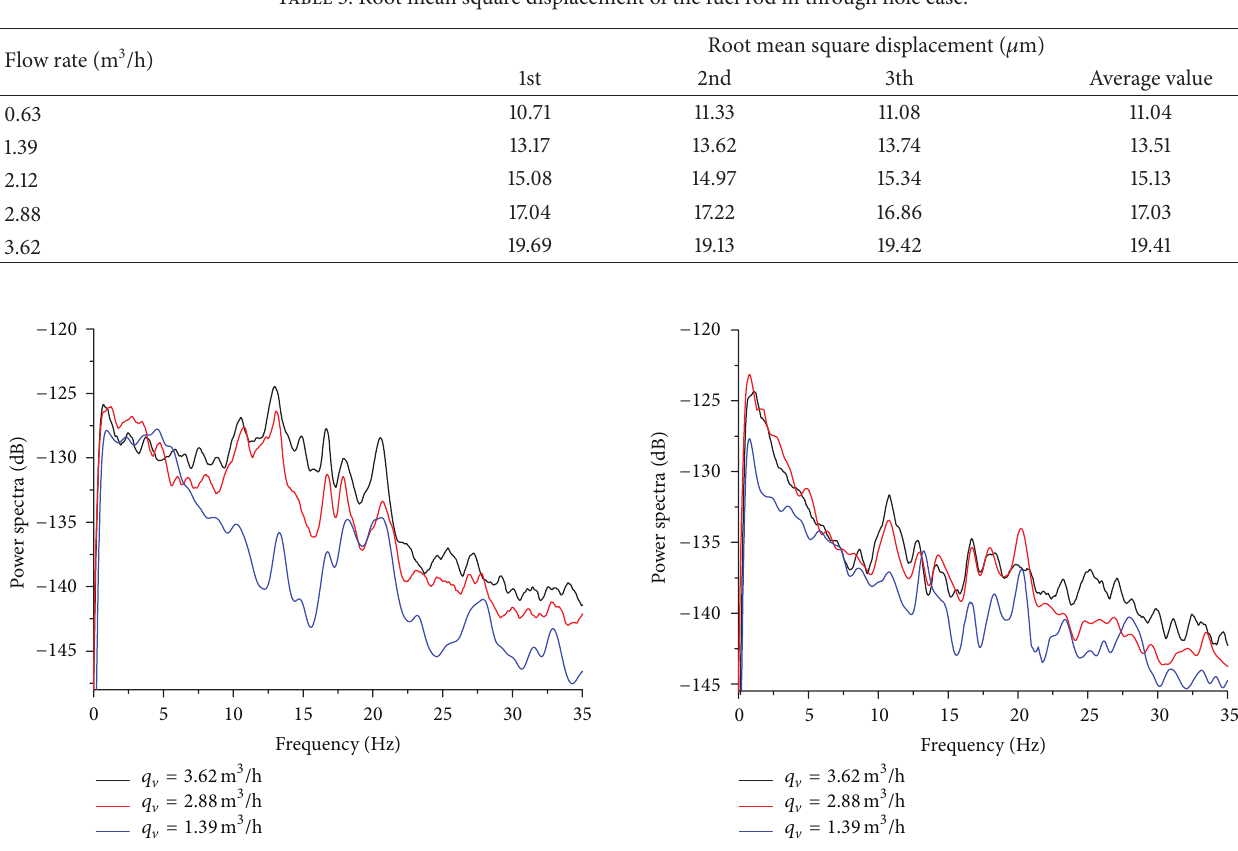
Table 3: Root mean square displacement of the fuel rod in through hole case.